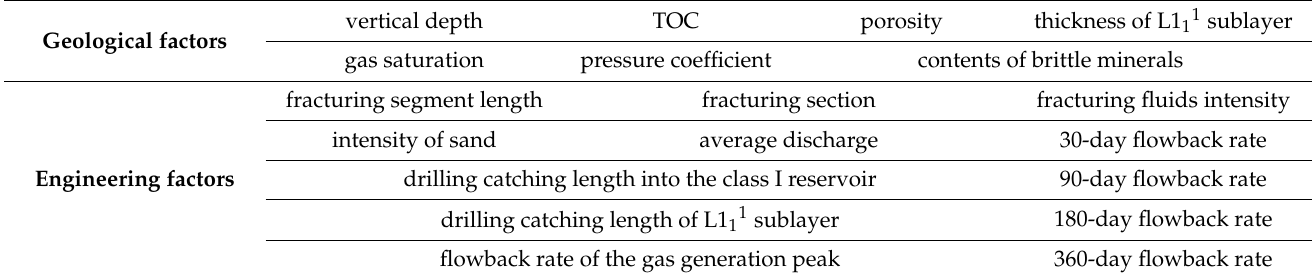
Table 1. Geological and engineering factors.